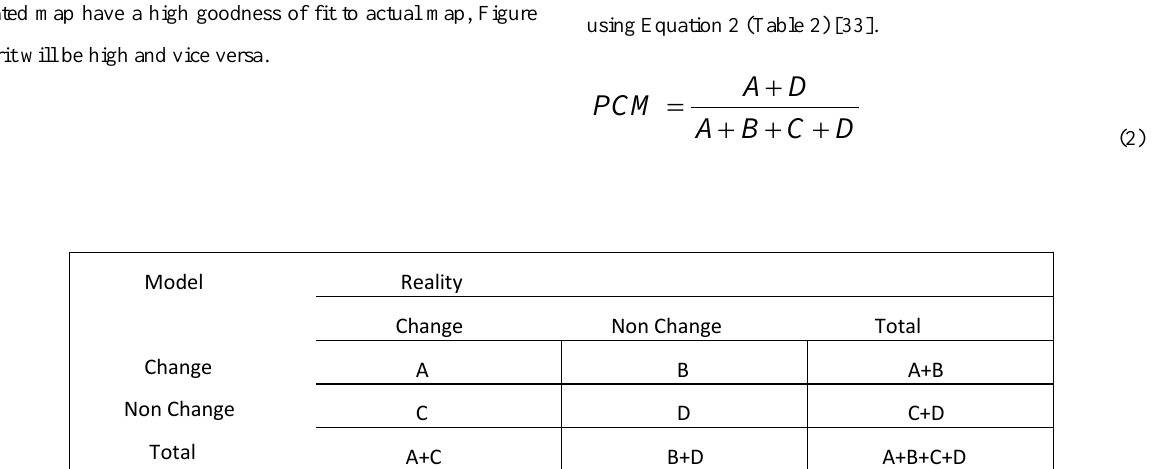
PCM Percent Correct Match (PCM) is a way to evaluate models of urban development. This method compares only the parameters of the original diameter of the A and D in the confusion matrix using Equation 2 (Table 2) [33].